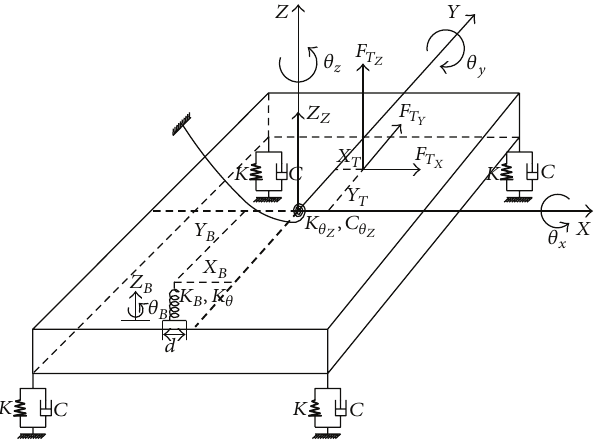
Figure 1: Theoretical model of the rigid plate with vibration absorb-